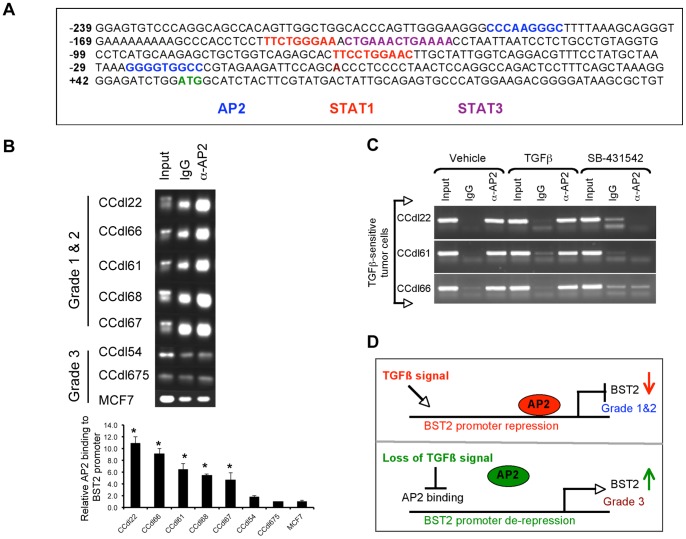
Differential AP2 binding to the BST2 promoter in primary breast cancer cell lines of varying histologic grade.
A. Schematic of the BST2 promoter region spanning 239 bp upstream of the transcriptional start site, including 111 bp of exon 1. Numbering is relative to the translation start site, highlighted in green (+1). Potential cis-regulatory elements shown are either on the plus (+) or minus (–) DNA strands. Regulatory binding sequences: AP2 (blue), STAT1 (red) and STAT3 (purple). B.
Top panel - Chromatin immunoprecipitation (ChIP) performed with anti AP2, or control IgG in 8 breast cancer cell lines. Significant AP2 recruitment to the BST2 promoter observed only in grade 1 (CCdl22, CCdl68, CCdl67) & grade 2 (CCdl66, CCdl61) cell lines. Bottom panel
 - DNA from ChIP samples in top panel analyzed by QPCR. Primers encompassing putative AP2 binding sites from −221 to +6 were used. Melt curves were analyzed to ensure amplification of a single product. Each reaction was performed in triplicate. The plot represents relative binding efficiency determined by 2-ΔΔCT, where ΔCT is the difference between input CT and immunoprecipitated CT; ΔΔCT is the difference between AP2-immunoprecipitated ΔCT and IgG-immunoprecipitated ΔCT. Asterisks represent statistical significance (p<0.01). C
. Inhibition of AP2 binding to the BST2 promoter in TGFβ-responsive primary breast cancer cell lines. Prior to processing for ChIP, cells were treated with vehicle, 4 ng/ml TGFβ, or 20 uM TGFβ inhibitor - SB-431542. Note striking reduction in AP2 binding in the presence of SB-431542 in 3 independent test cell lines. D. Hypothetical representation of BST2 transcriptional regulation by the TGFβ axis. Intact TGFβ regulation mediated by AP2 binding to the BST2 promoter enables maintenance of low baseline expression in grade 1 & 2 breast cancer cells.